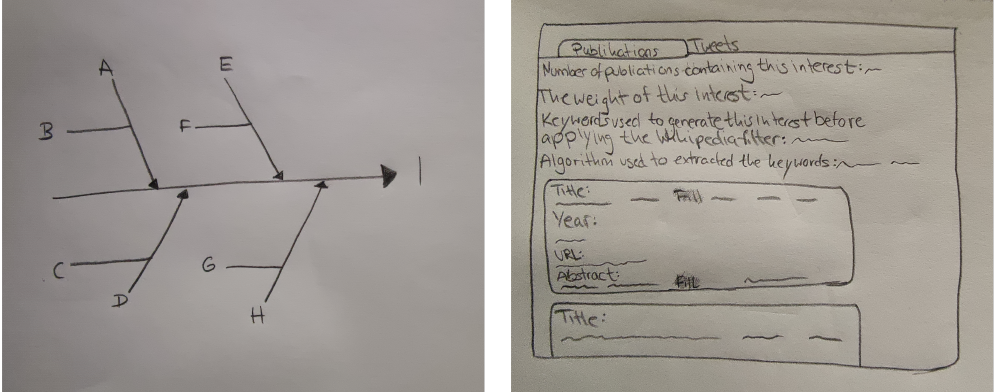
Figure 6. Understand: Visualizing the interest model generation process.